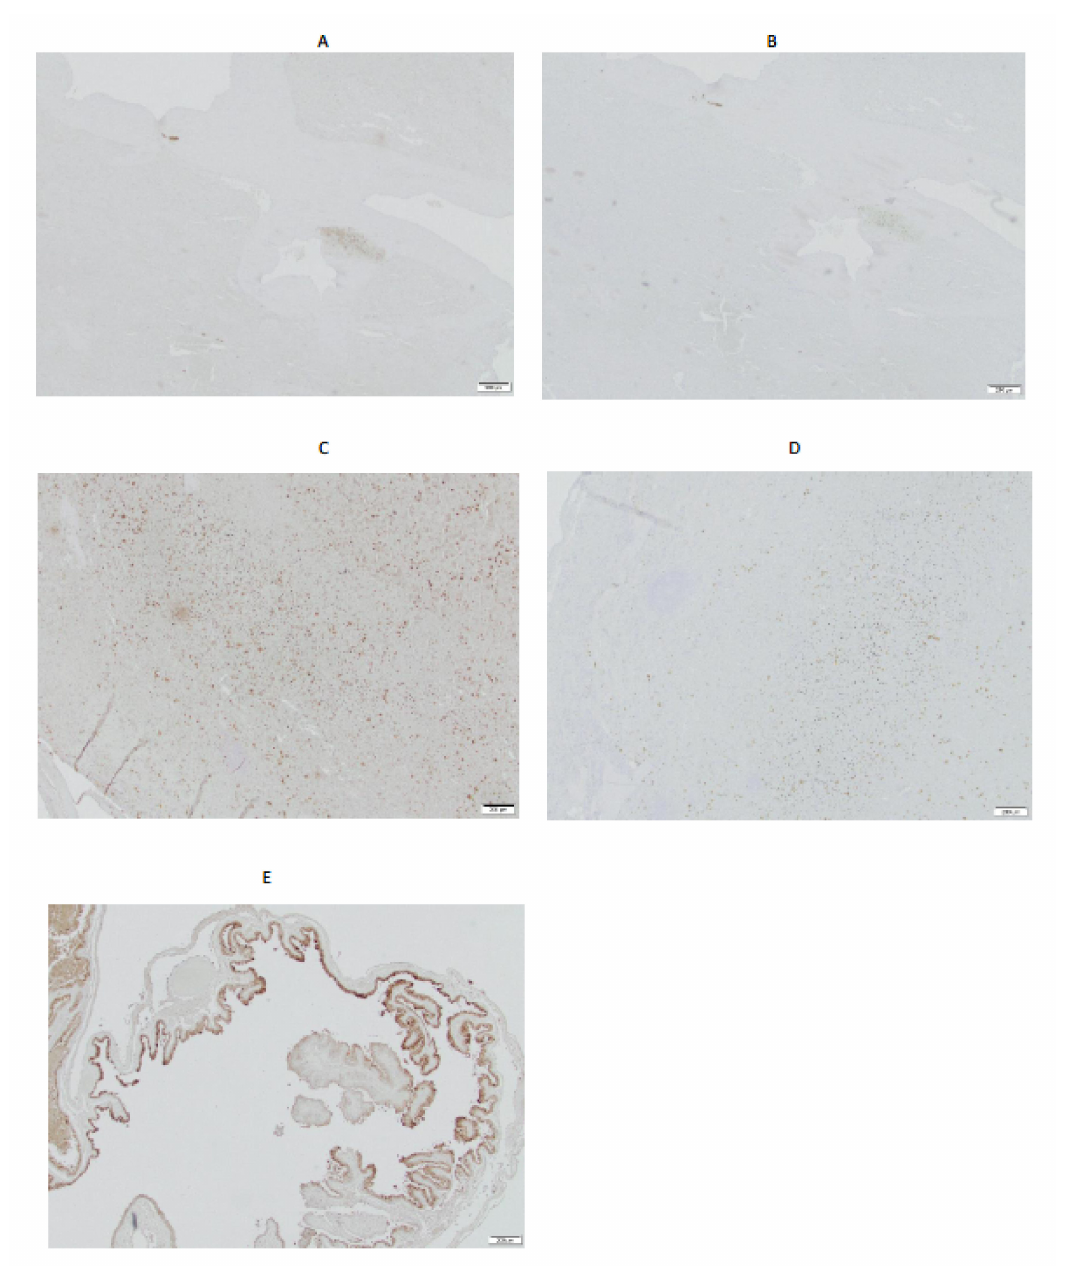
Figure 4. Immunohistochemistry of canine spleens with 2G11 IGF2R-specific antibody. ( A ) spleen, case # PDS 2114514, 2G11 mAb; ( B ) spleen, case # PDS 2114514, MOPC21 control mAb; ( C ) spleen, case # 2128371, 2G11 mAb; ( D ) spleen, case # 2128371, MOPC21 control mAb; ( E ) canine placenta, 2G11 mAb. Size bar—200 µ